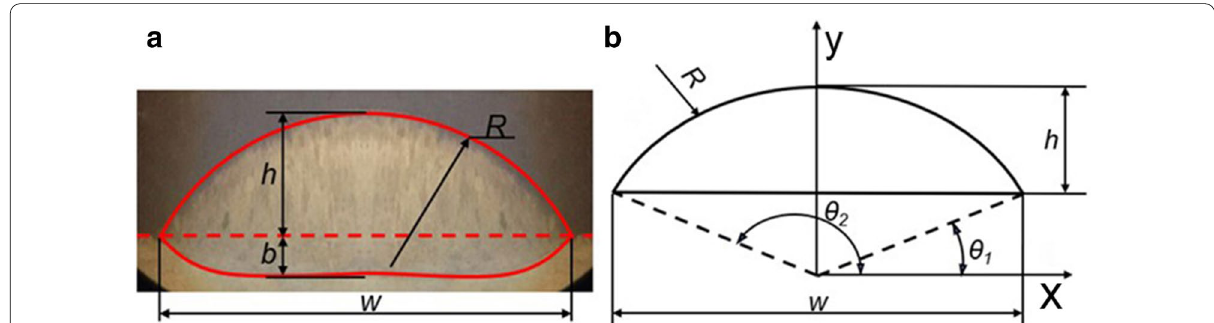
Figure 3 Geometrical characteristics of clad: a micrograph and b geometric model of cladding